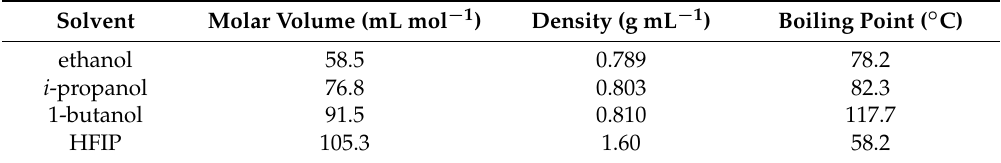
Table 1. Properties of the polar solvents used in this study. HFIP =